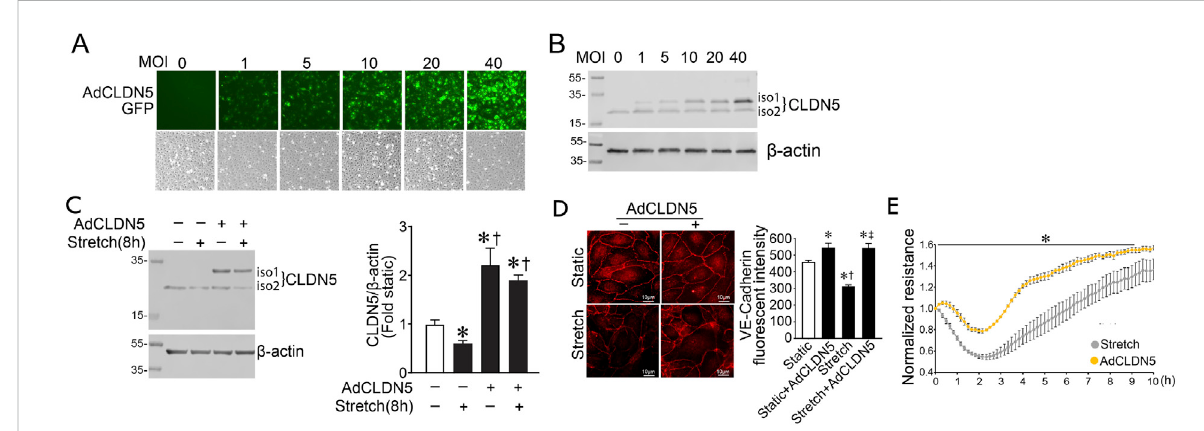
FIGURE 4 Claudin fi ve overexpression prevents the loss of barrier function in human lung microvascular endothelial cells exposed to cyclic stretch. A CLDN5/GFP coding adenovirus was used to overexpress Claudin-5 isoform 1. HLMVECs were treated with AdCLDN5 for 48 h with an MOI of 40 unless otherwise indicated. HLMVEC lysates were subjected to immunoblot analysis using Claudin-5 antibody. HLMVECs were analyzed by immuno fl uorescentstainingusingaVE-cadherinantibody.TreatmentofHLMVECswithAdCLDN5inducedaproportionalincreaseinclaudin-5 as observed by increased GFP reporter fl uorescence (A) . Immunoblotting shows a similar proportional increase in Claudin-5 protein levels (B) . Total Claudin-5expression(iso1+iso2)issigni fi cantlyincreasedinHLMVECspretreatedwithAdCLDN5andsubjectedornottocyclicstretchrelativetothe non-adenovirus pretreated cells (C) . Overexpression of Claudin-5 prevents VE-cadherin loss after cyclic stretch in HLMVECs (D) . The transendothelial resistance reduction in HLMVECs subjected to cyclic stretch is ameliorated in cells overexpressing Claudin-5 (E) . * p < 0.05 versus Static (C,D) or AdCLDN5 (E) , † p < 0.05 versus Stretch (C) or Static + AdCLDN5 (D) , ‡ p < 0.05 versus Stretch. N = 4 – 6 (C) ; N = 30 – 42 (D) ; N = 3 – 4 (E)